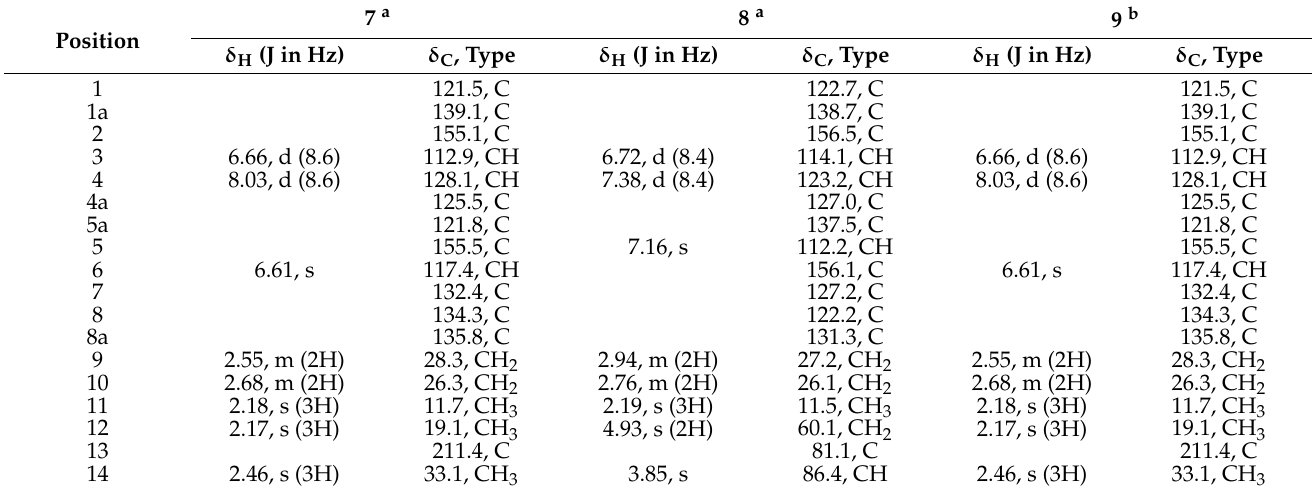
Table 3. 1 H (500 MHz) and 13 C (125 MHz) NMR data of compounds 7–9 .